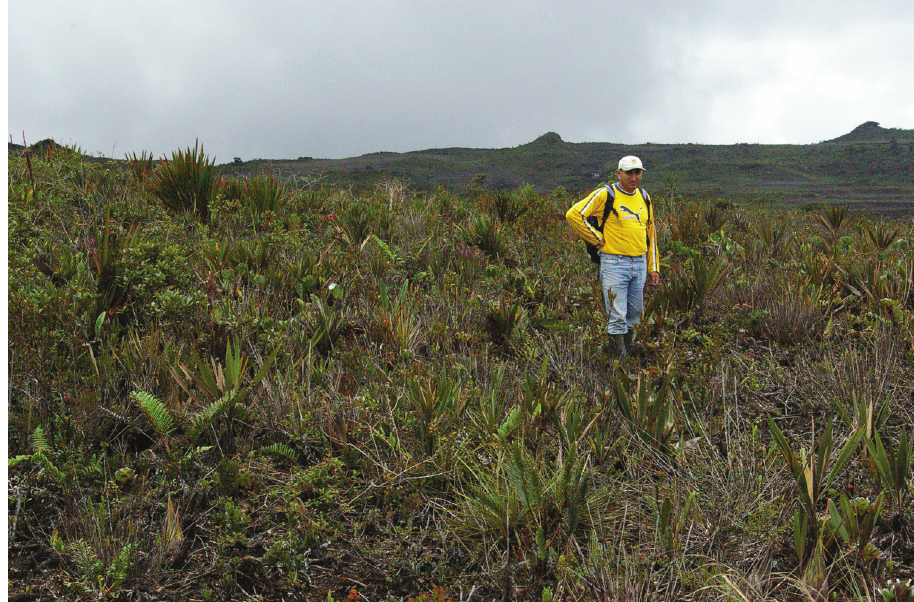
Figure 5. Vegetation at the summit of the Machinaza plateau, Cordillera del Cóndor, Ecuador, 2450 m (photograph D.A.